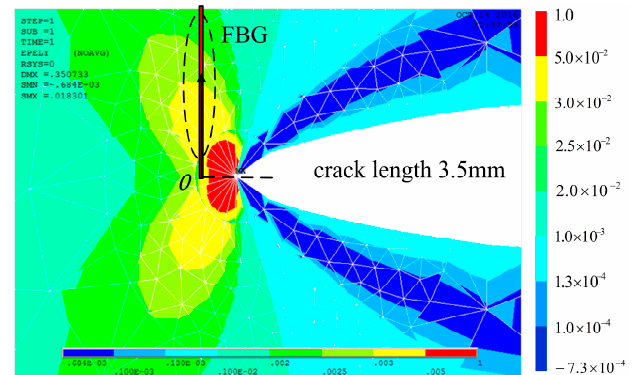
Figure 10. Finite element analysis of a crack with a length of 3.5 mm.